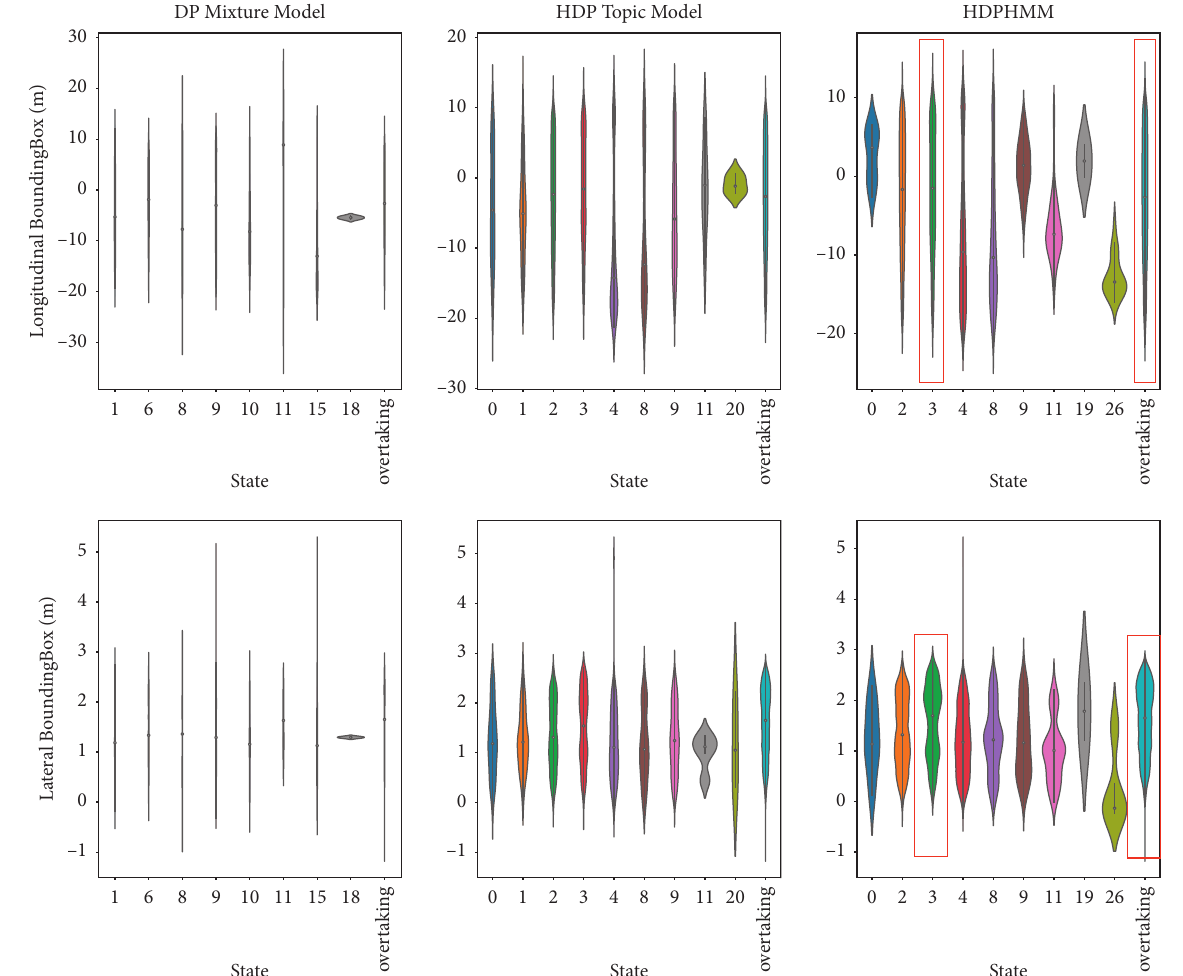
Figure 13: Comparison of locations of points in each